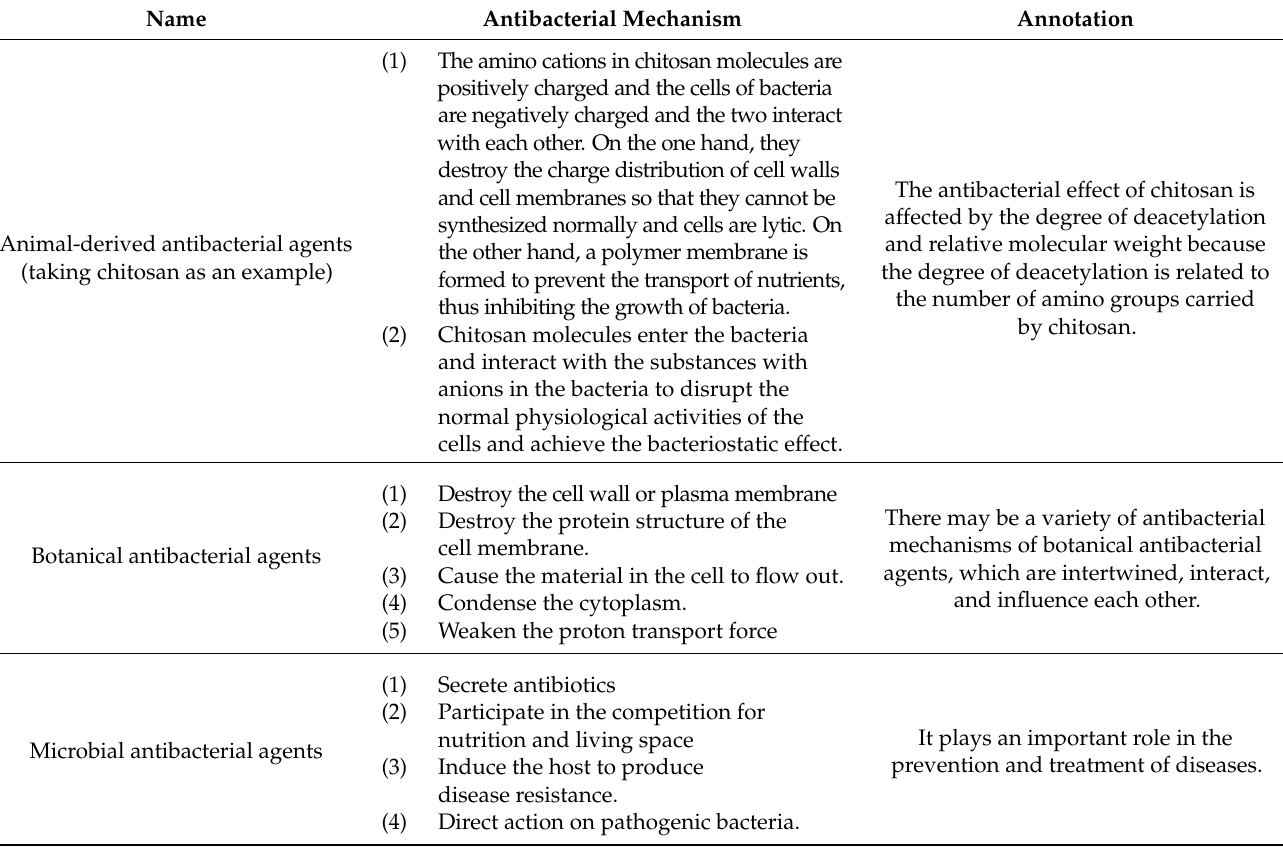
Table 3. Antibacterial mechanisms of natural antibacterial agents